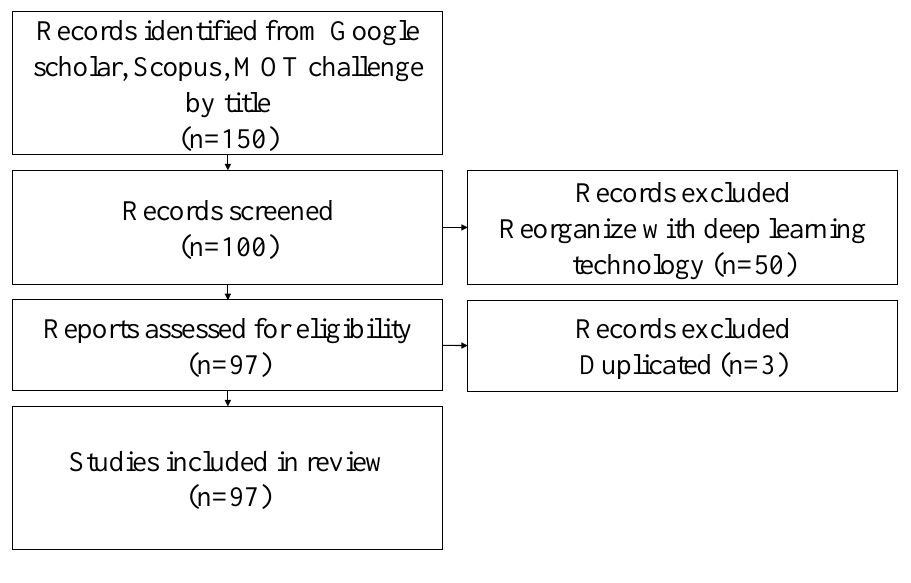
Figure 4. The search methodology for this paper.